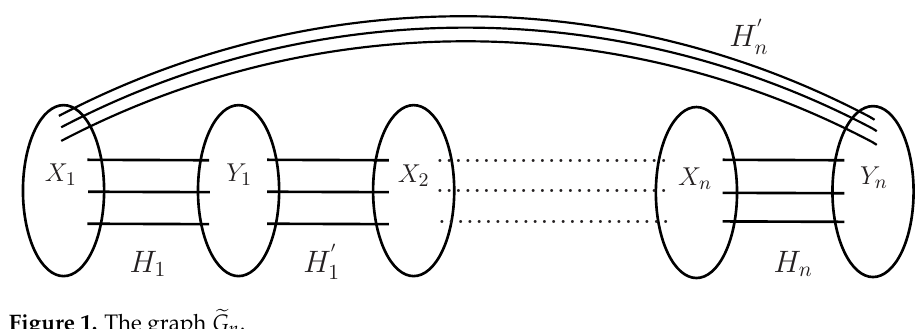
Figure 1. The graph (cid:101) G n